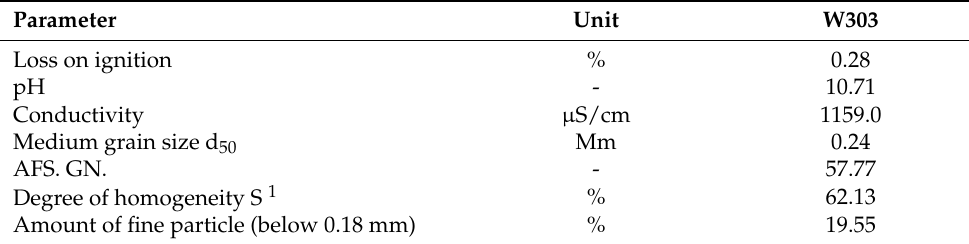
Table 2. General parameters of studied core mixtures.